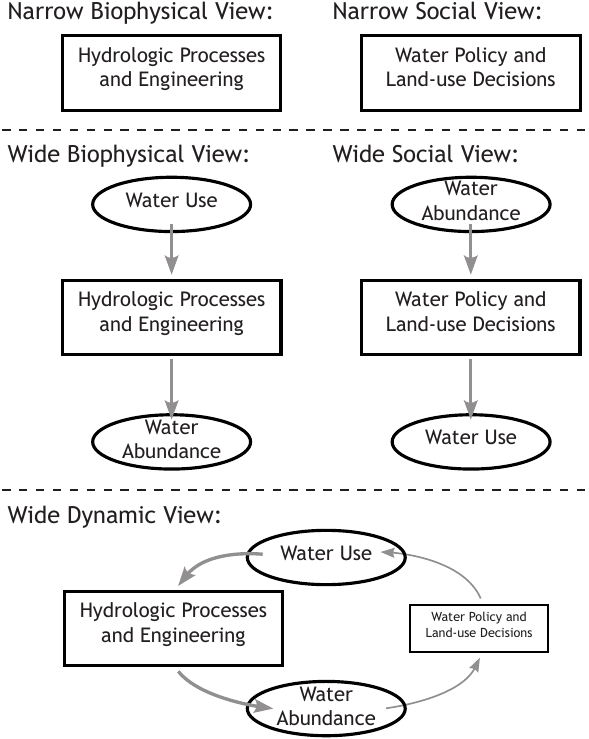
Fig. 2. Diagram illustrating the three lenses through which a com- ponent of a human-environment system can be viewed. The top panel shows a narrow disciplinary view of an issue, from either a biophysical or social perspective. External variables and cause-and- effect relationships are viewed through the wide lens, as shown in the middle panel. The bottom panel shows a wide-dynamic view from the biophysical perspective, in which the core component is the focus of the analysis, but the whole system, including feedbacks, is